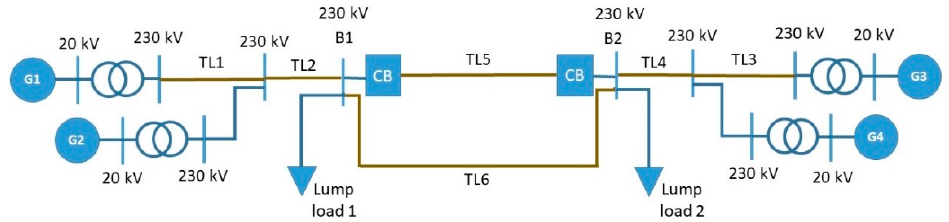
Figure 7. Single line diagram of the two-area Kundur network.